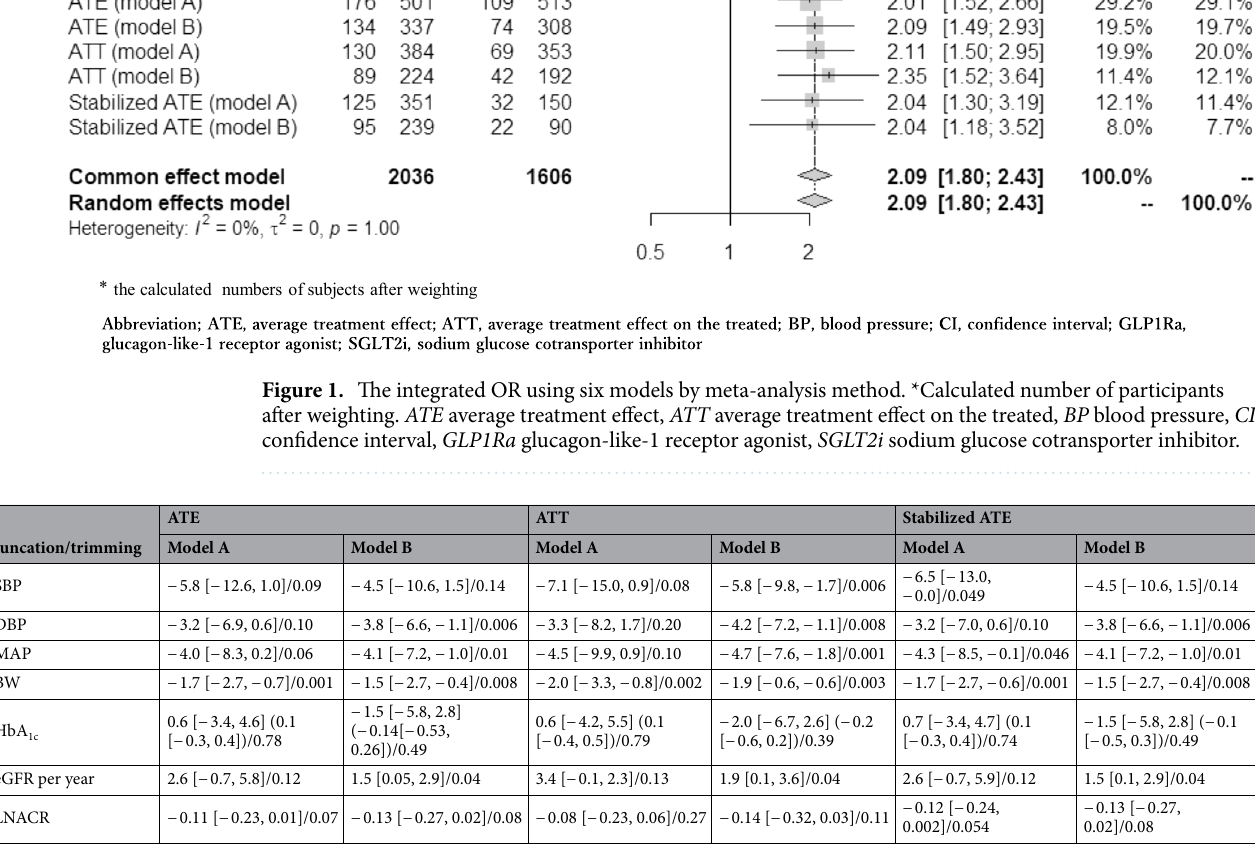
Table 6. The changes of the clinical characteristics after SGLT2i treatment compare to GLP1Ra treatment by the analysis of the generalized linear model. Data present as the difference [95% CI]/ P -value. The truncation on 99 percentiles is utilized in model A, and the trimming by 0.05 ≦ PS ≦ 0.95 is utilized in model B. Δ change, BW body weight, CI confidence interval, DBP diastolic blood pressure, eGFR estimated glomerular filtration rate, HbA 1c glycated hemoglobin A 1c , LnACR logarithmic value of urine albumin-to-creatinine ratio, MAP mean arterial pressure, SBP systolic blood